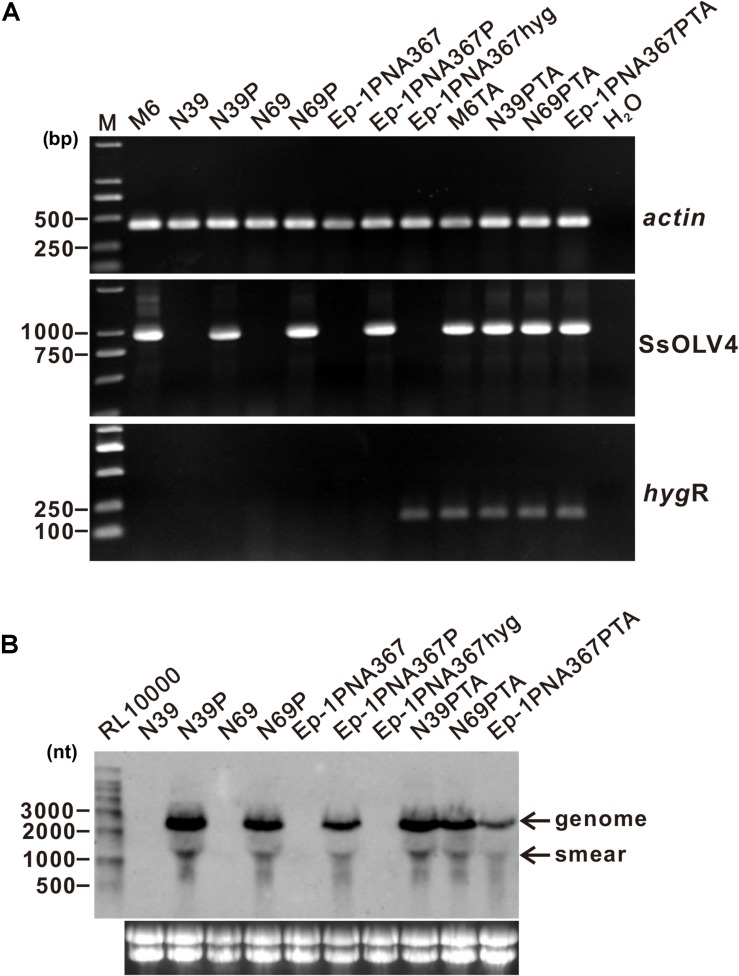
Detection of the synthesized viral RNA in the strains transfected using protoplasts as the receptor. (A) SsOLV4 RNA was detected by RT-PCR amplification from the transfected subcultures. Total RNA of each strain was used to synthesize cDNA. Gene actin was amplified as an internal control using primers ActinF and ActinR. Primers are listed in Supplementary Table S1. DNA was stained with ethidium bromide. Size of the DNA ladder standard is indicated in base pairs. (B) Northern hybridization to confirm the presence of SsOLV4. Total RNA from the strains was extracted from S. sclerotiorum mycelia grown for 2 days on PDA covered with cellophane. Each RNA sample was about 20 ng in total. Marker RL10000 (Takara) was detected using probe control DNA in alkaline Direct Labeling System (GE Healthcare). Lower panels are ethidium bromide-stained gels showing rRNA. The probe (location shown in Figure 2A) was synthesized with primers OMVFA and OMVR2 using PCR and directly labeled with alkaline phosphatase and detected by CDP-Star (GE).